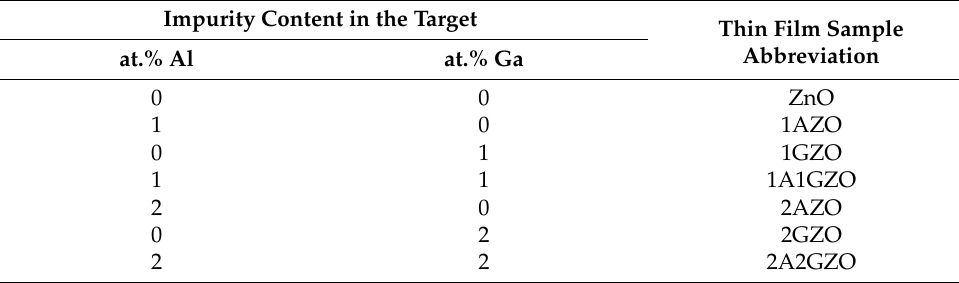
Table 1. Impurity composition of the sputtered ZnO-based ceramic targets and the corresponding abbreviation of the deposited films. Impurity Content in the Target